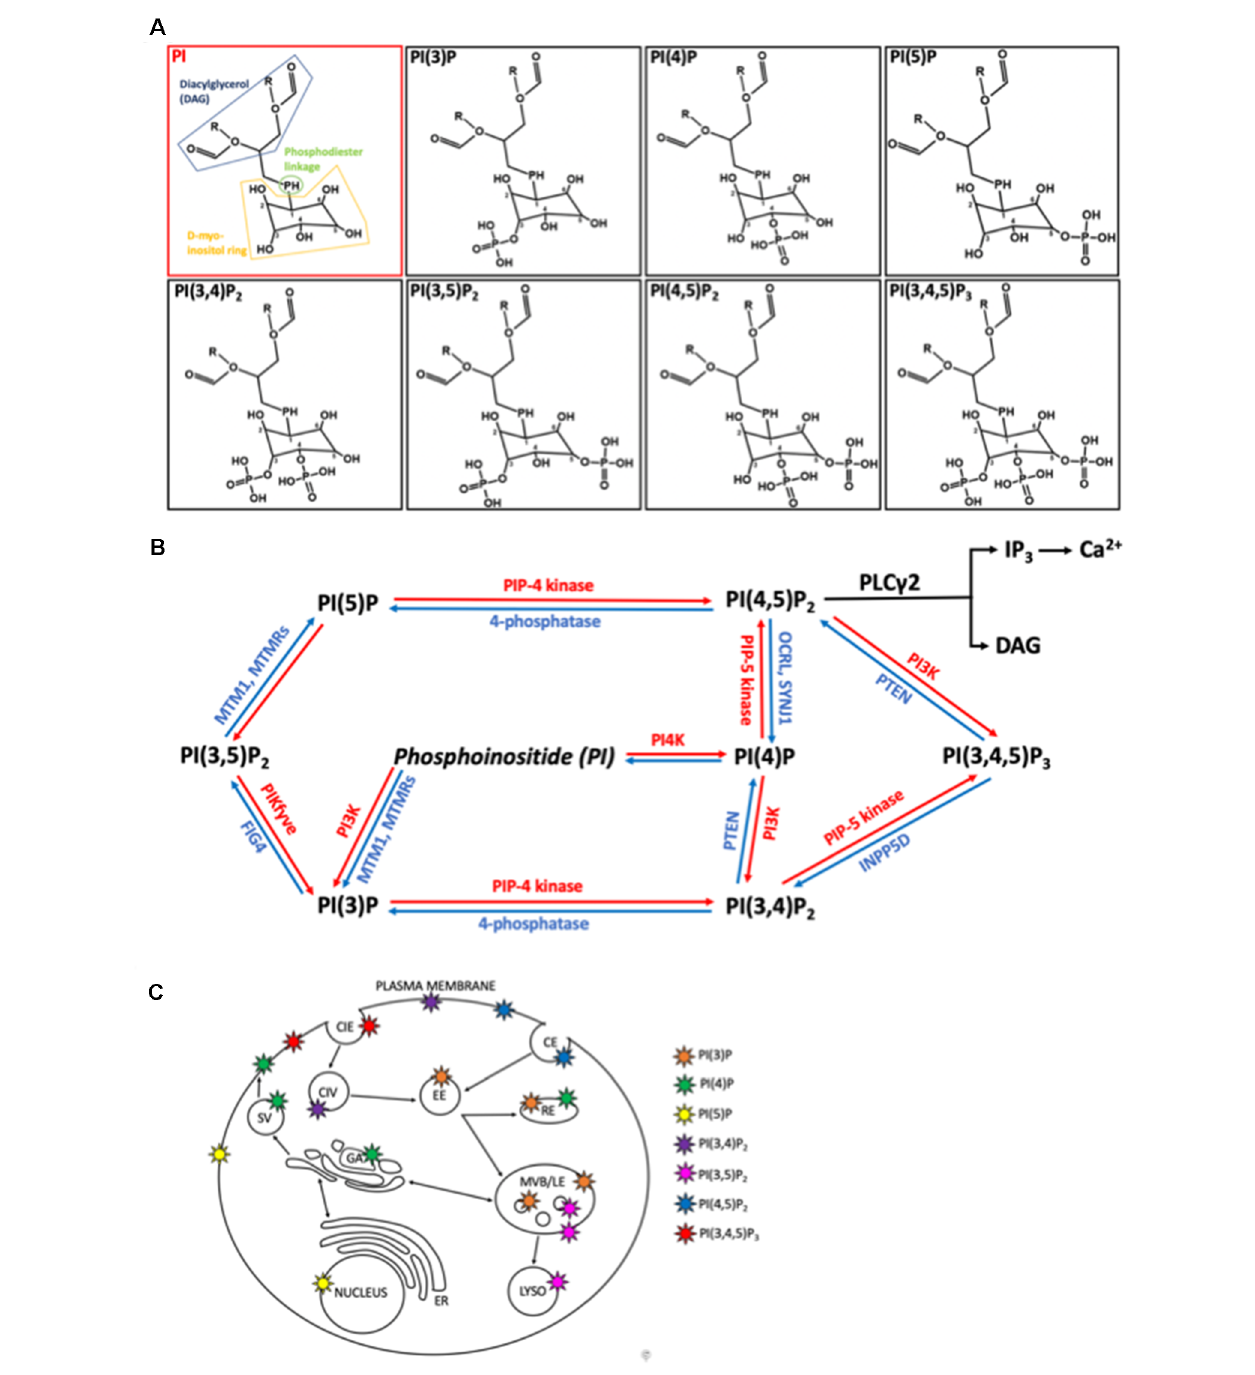
FIGURE 1 | Structure, metabolism, and location of phosphatidylinositides (PIPs) within mammalian cells. (A) Structures of phosphatidylinositol (PI) and it is seven phosphoinositide (PIP) derivatives, generated by phosphorylation of the inositol ring at positions 3, 4 or 5. PI consists of diaglycerol (DAG, blue) bound to a D-myo-inositol ring (yellow) via a phosphodiester linkage (green). O, oxygen; H, hydrogen; P, phosphate; R, non-polar fatty acid tails. (B) Metabolic pathways regulating the interconversion of PIP species. Lipid kinases (red) phosphorylate the inositol ring at points 3, 4, or 5 to generated more phosphorylated PIPs while lipid phosphatases remove phosphate groups. MTM1, myotubularin1; MTMR, myotubularin-related protein; FIG4, Factor-Induced Gene 4; PTEN, phosphatase and tensin homolog; OCRL, inositol phosphatase 5-phosphatase; SYNJ1, synaptojanin 1; INPP5D, Src homology 2 (SH2) domain containing inositol polyphosphatase 5-phosphatase 1. (C) Primary locations of the different PIPs within the cell are shown by the colored stars. CIE, clathrin independent endocytosis; CIV, clathrin independent endocytic vesicle, CE, clathrin dependent endocytosis; EE, early endosome; RE, recycling endosome; SV, secretory vesicle; GA, golgi apparatus; ER, endoplasmic reticulum; MVB/LE, multi-vesicular body/late endosome; LYSO, lysosome.